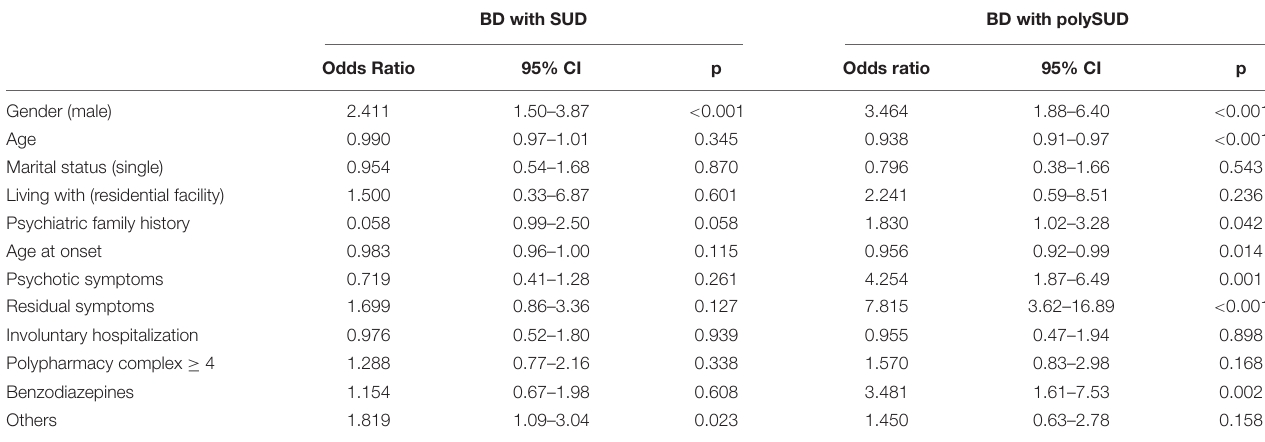
TABLE 3 | Multinomial logistic